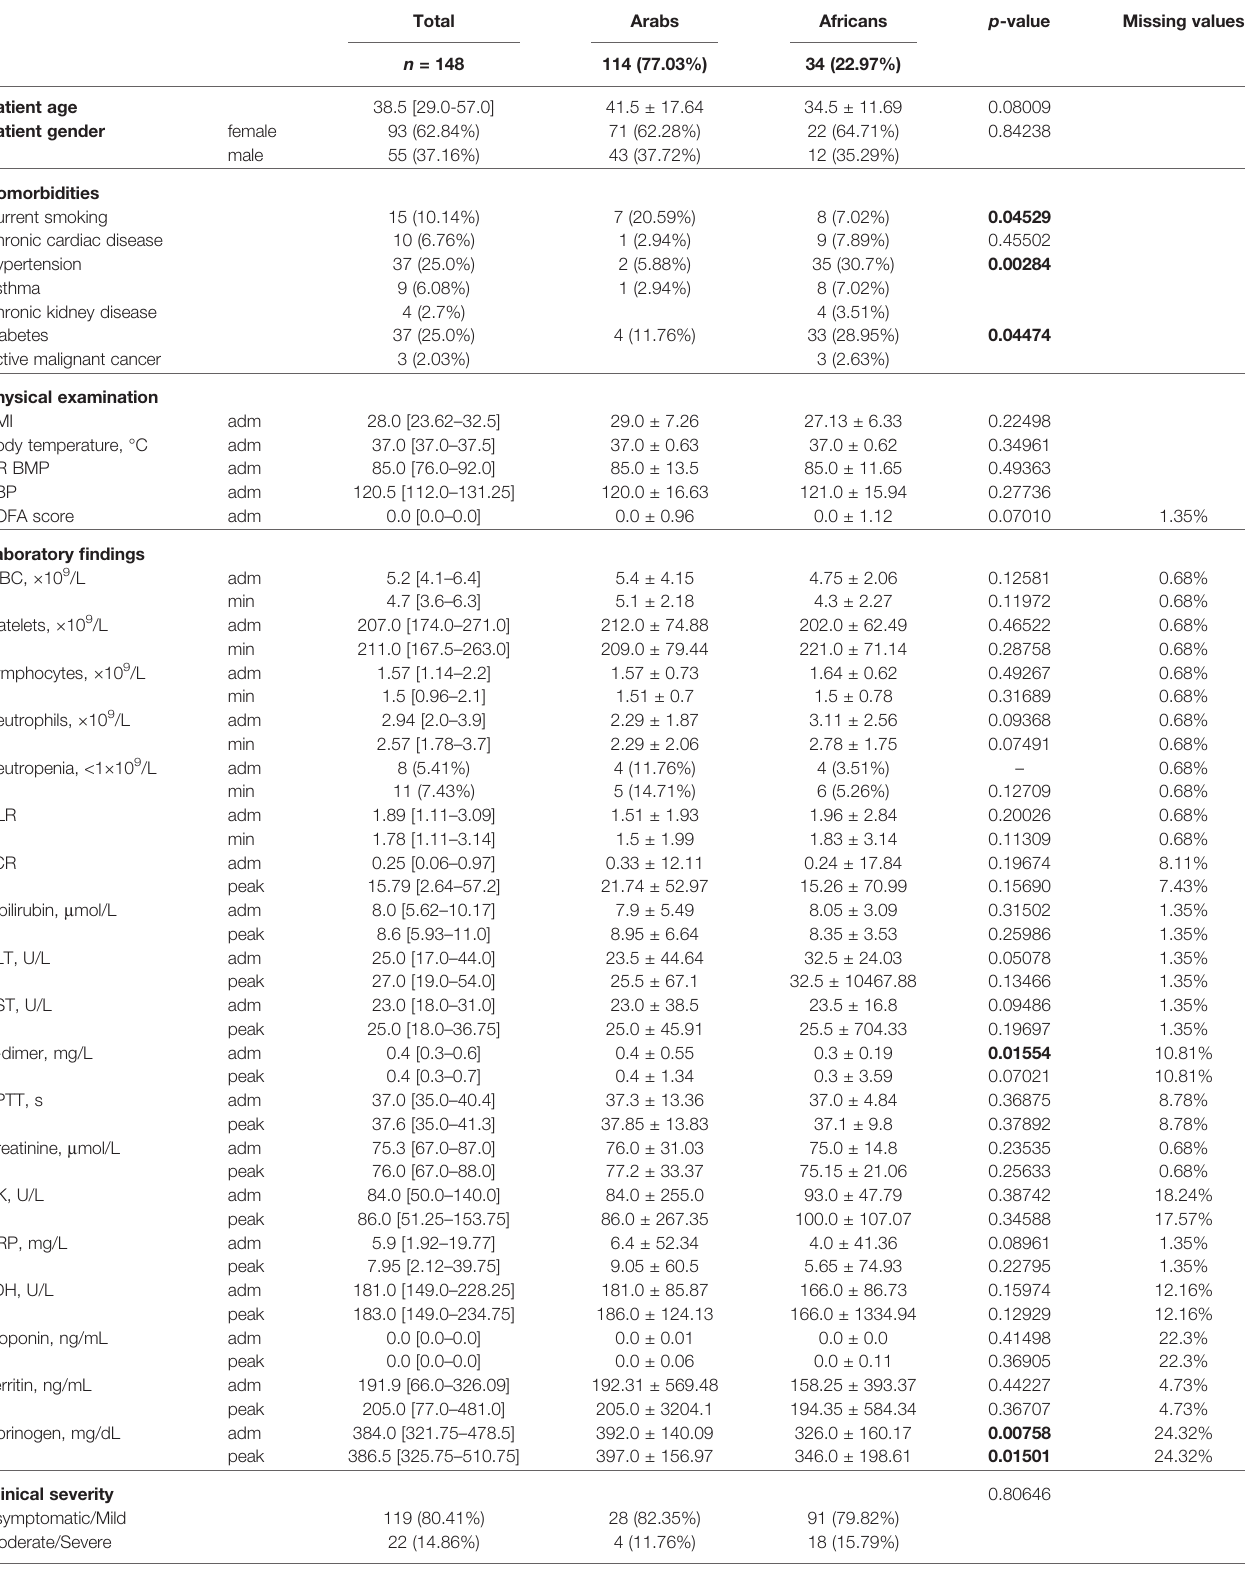
TABLE 4 | Comparison of patients of Middle Eastern